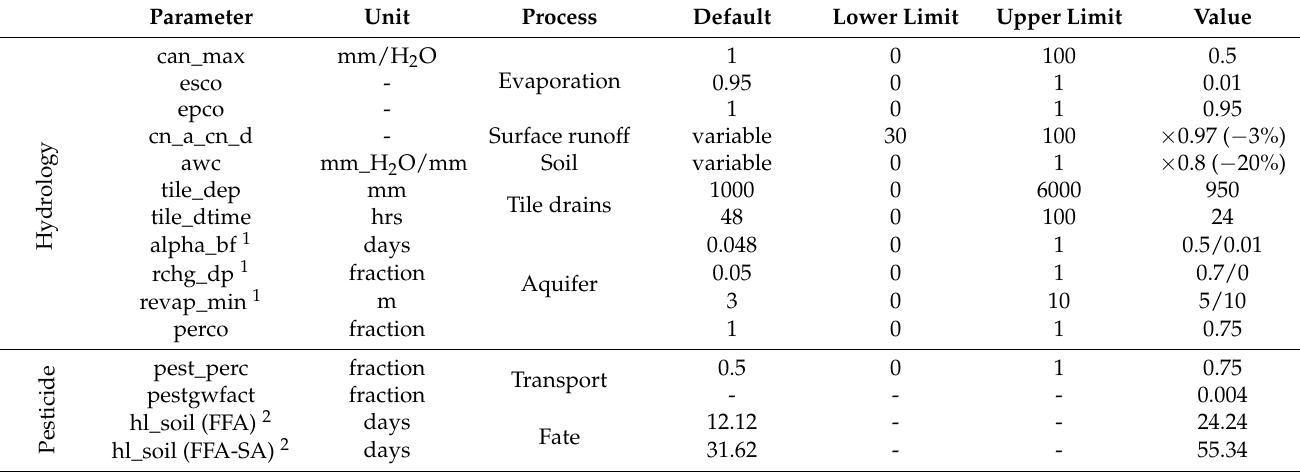
Table 3. SWAT+ input parameters selected for calibration and final calibrated